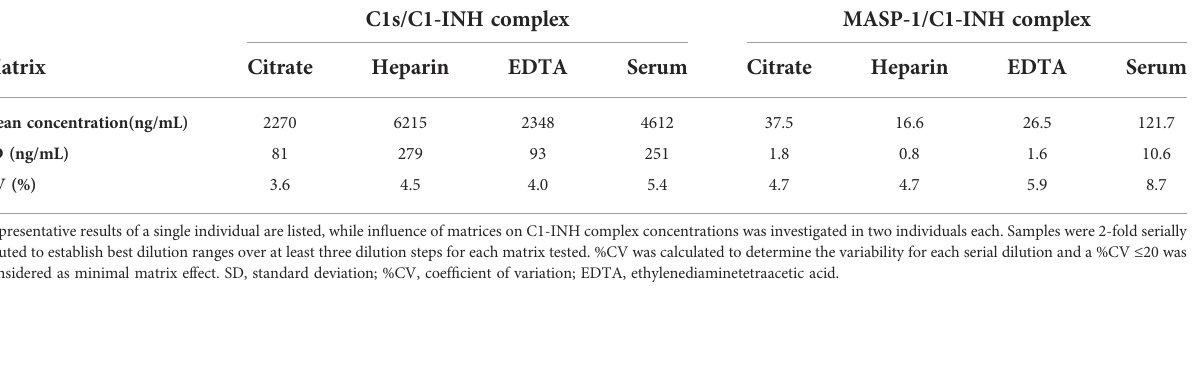
TABLE 1 Analysis of different matrices.